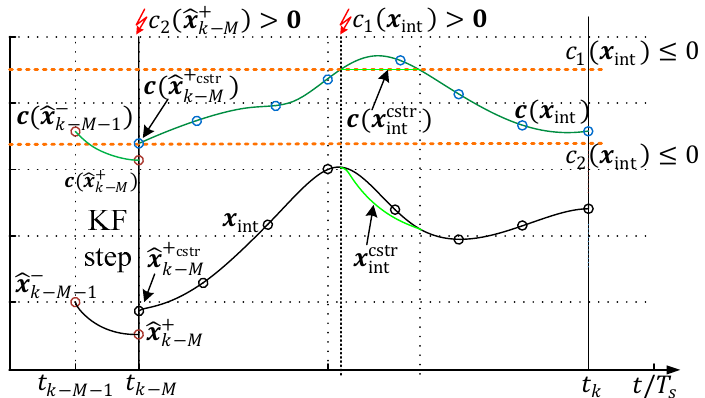
Figure 12. Constraint violation detection and handling within the moving window.